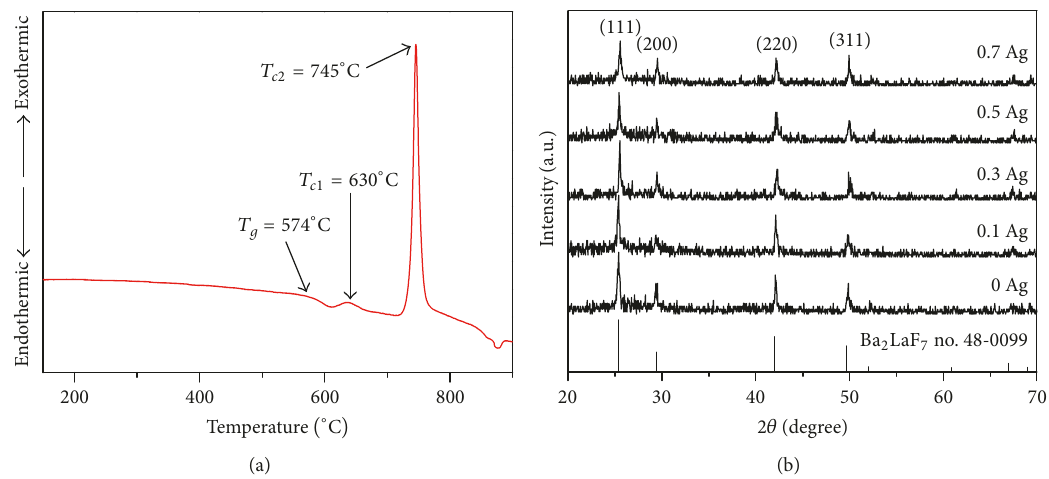
Figure 1: (a) DSC of 0.5 Ag sample. (b) XRD patterns of glass ceramic samples with different Ag